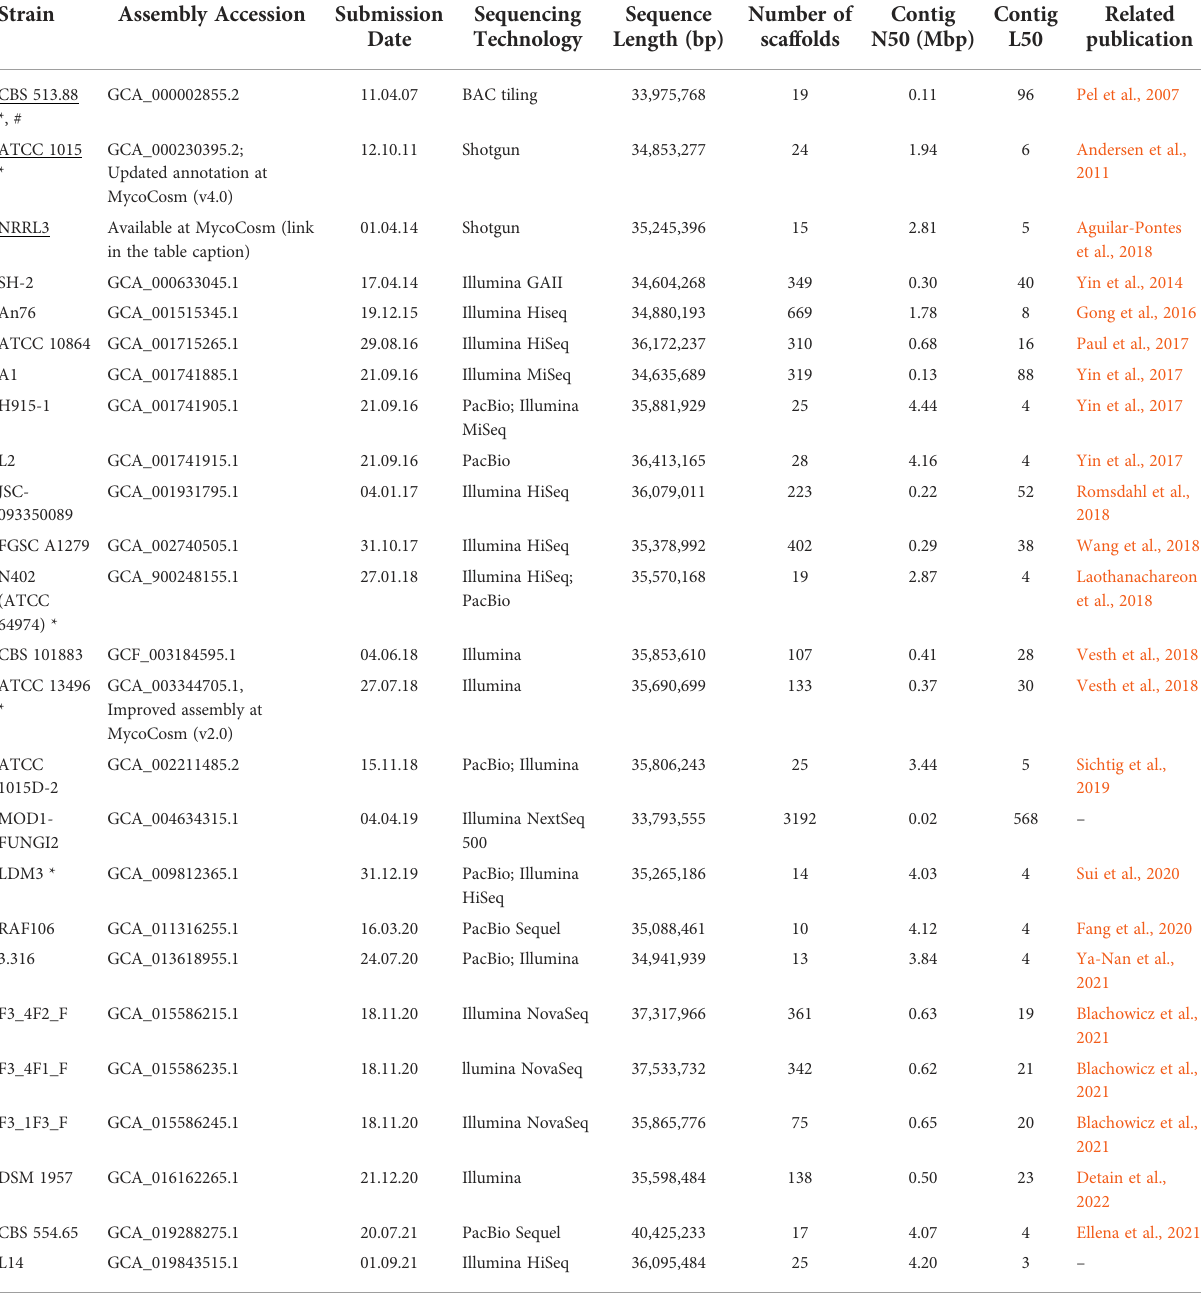
TABLE 1 Overview of the available A. niger genome